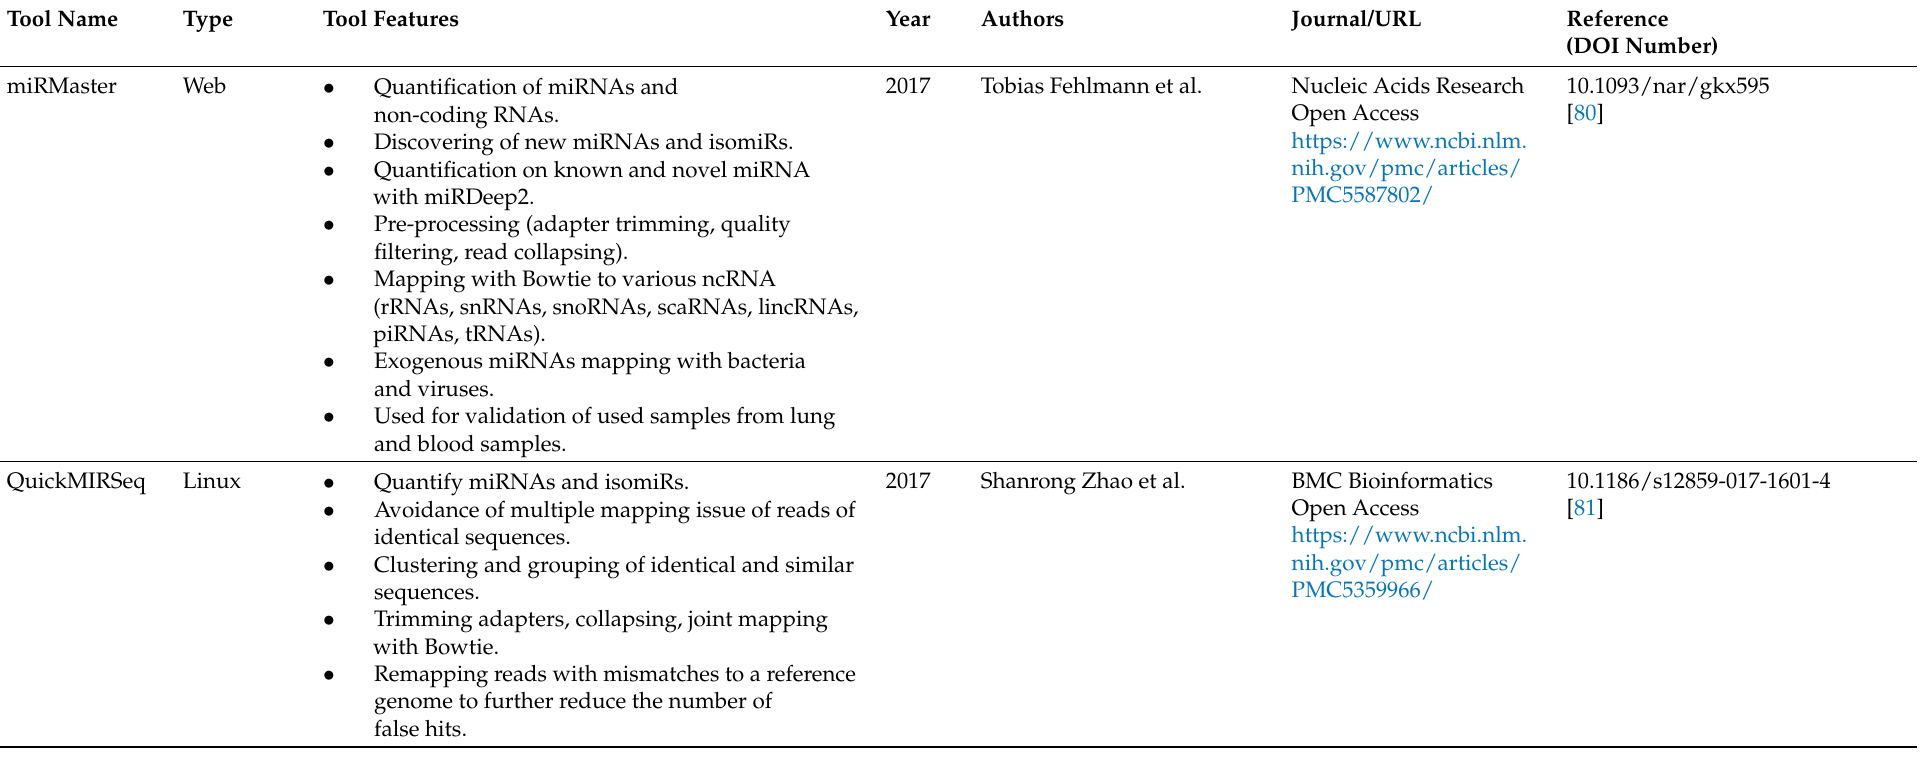
Table 1. List of bioinformatics tools for isomiR identification and analysis in next-generation sequencing (NGS) datasets (The table can be accessed also at https://github.com/Glogobyte/